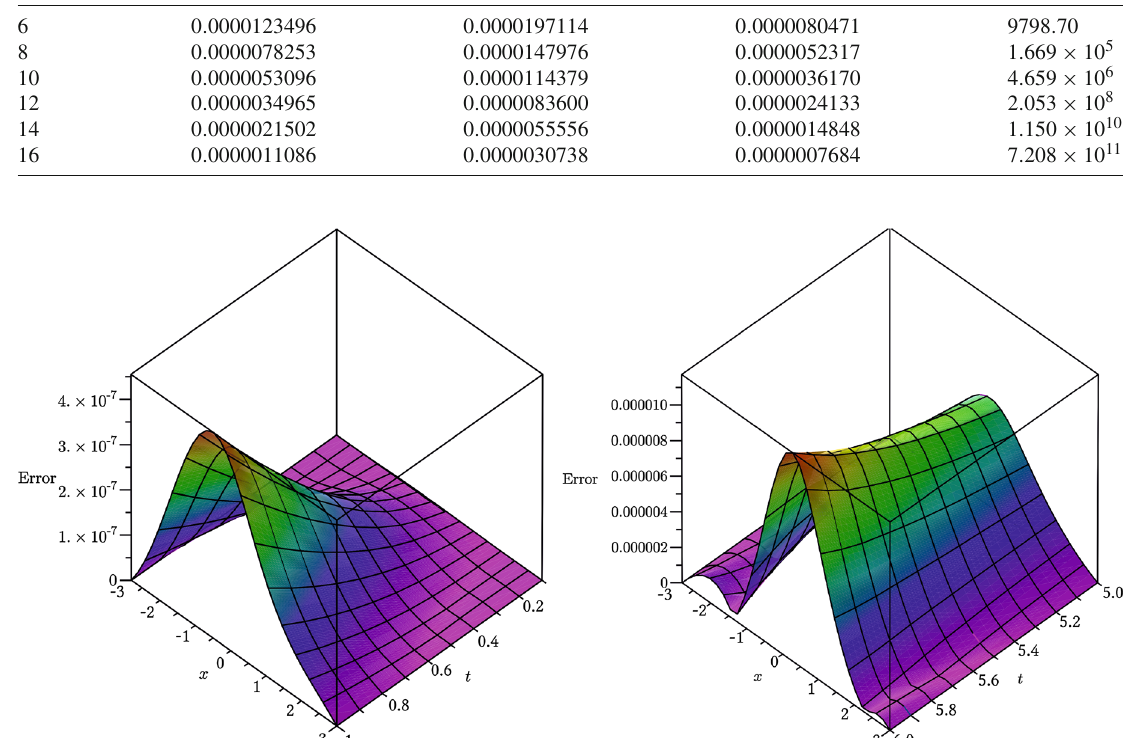
Fig. 3 Plot of the absolute error function in − 3 ≤ x ≤ 3 for 0 ≤ t ≤ 1 (left) and 5 ≤ t ≤ 6 (right) with M = 31, α = 0 . 5, τ = 0 . 1 and c = 3 . 5 using GS-RBFs in Example